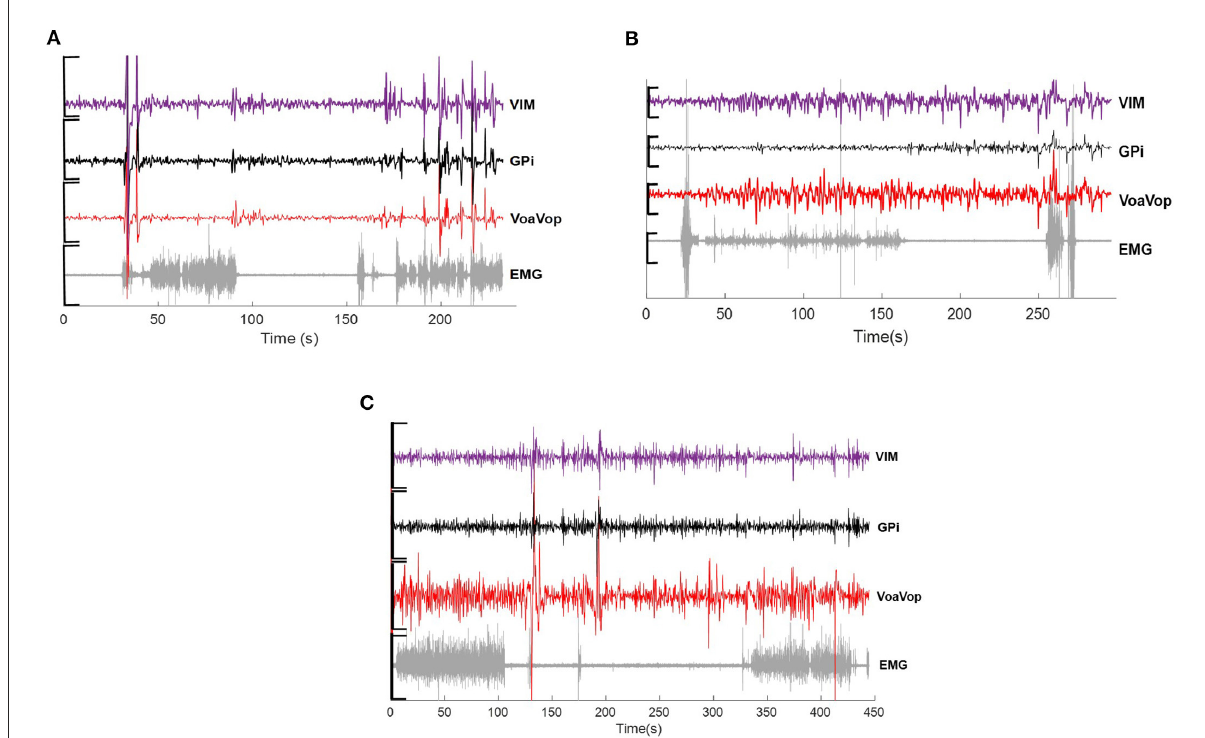
FIGURE1 Example of raw data across microwire electrodes placed on Vim (purple), GPi (black), VoaVop (red) and muscle (sEMG, grey), showing changes in activity during drawing task for (A) hemidystonia. (B) generalized dystonia and (C) Tourette patients. Vertical axis: voltage [ − 5 to 5 uV)]. Horizontal axis: time